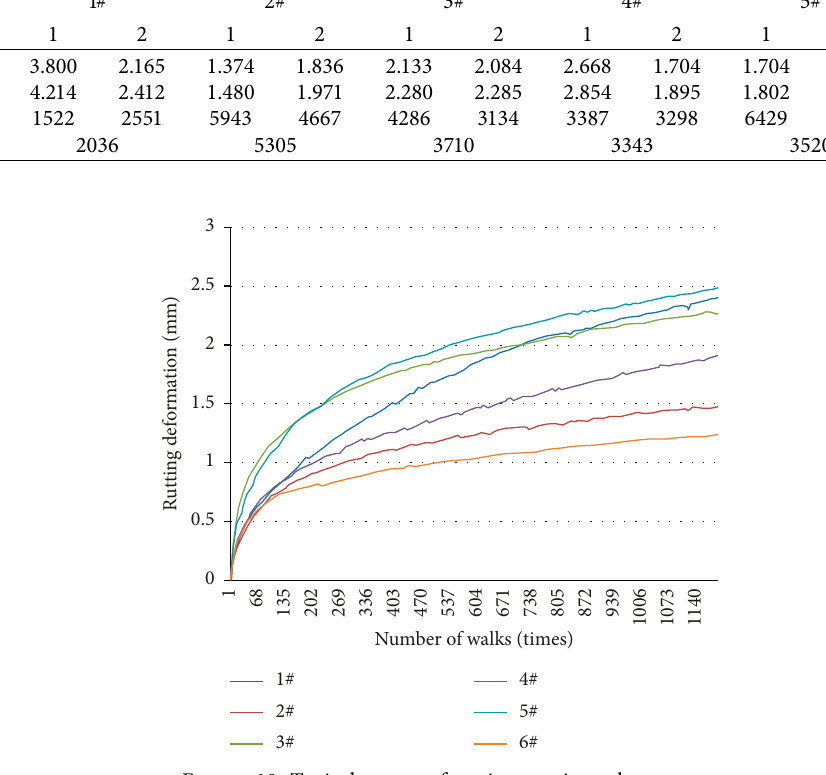
Figure 10: Typical curves of rutting test in each